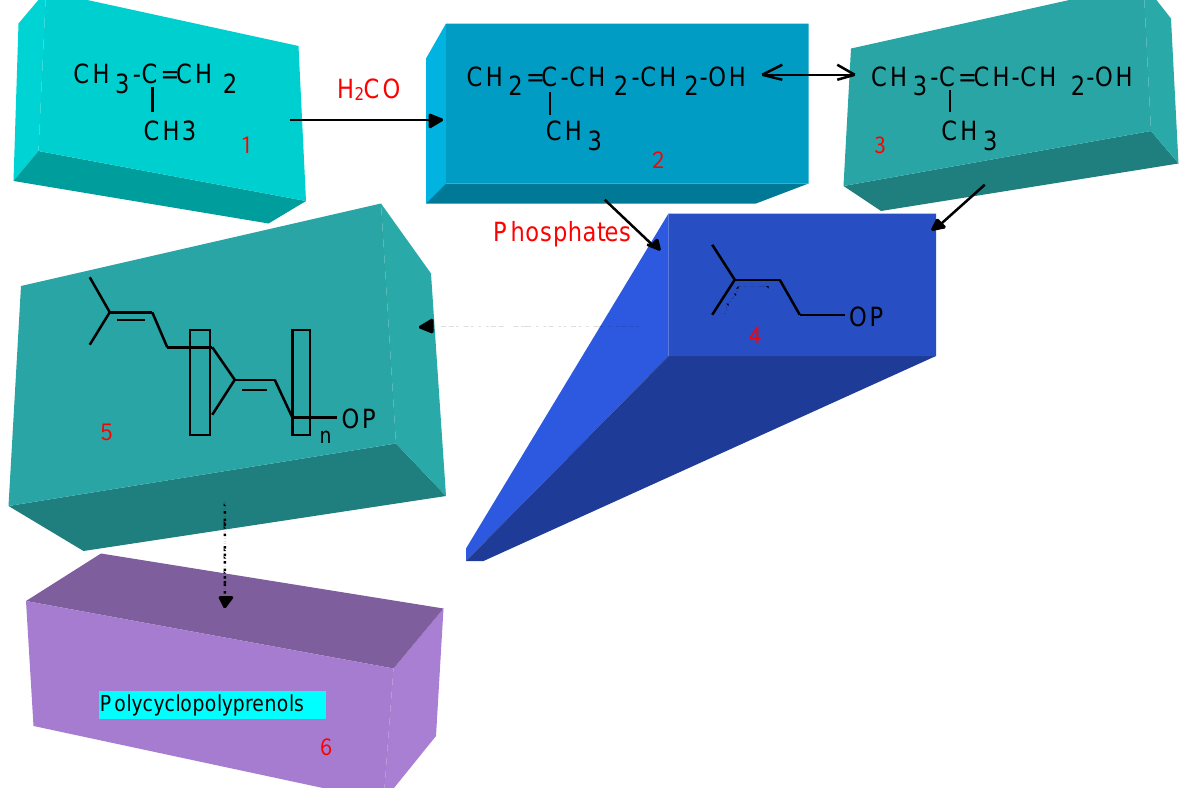
Scheme 1. Scheme of the synthesis of terpenoids from isobutene and